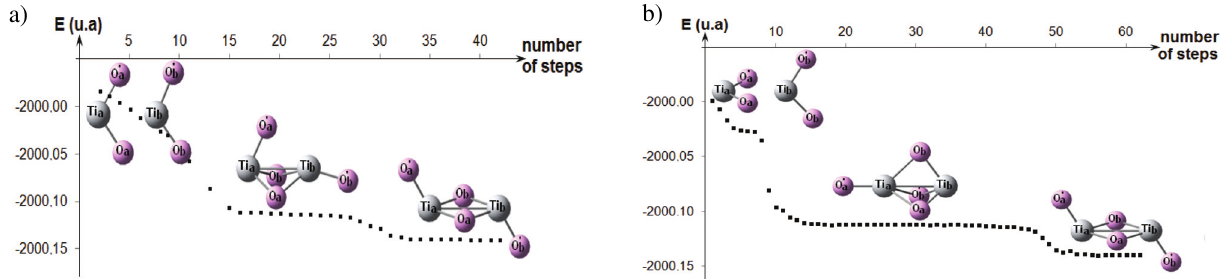
Figure 4 . Energetic optimization profiles of separated TiO